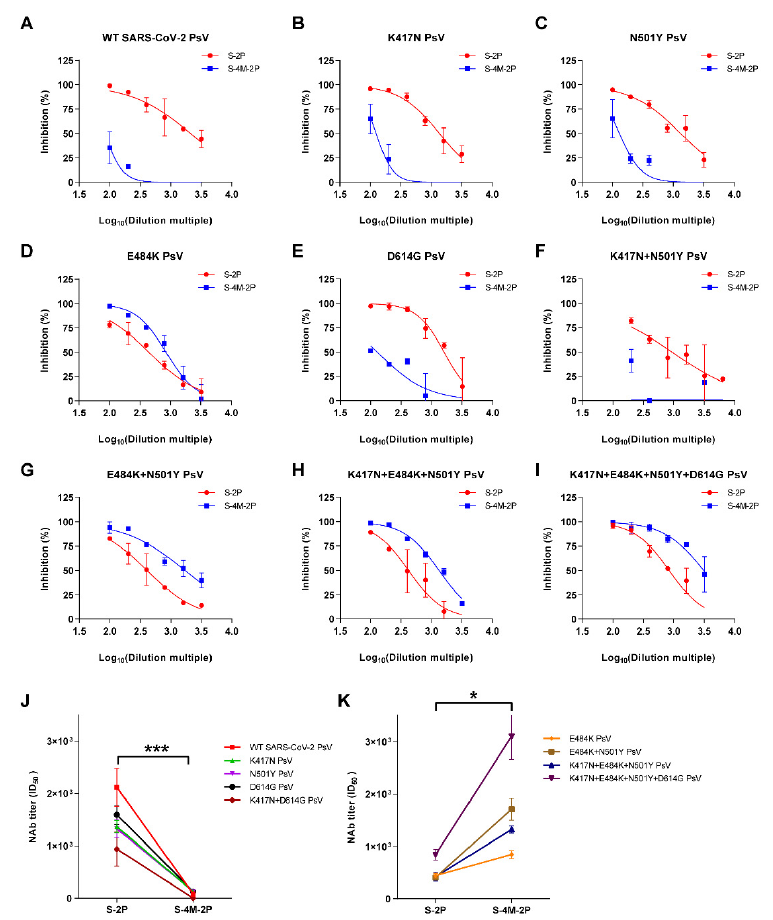
Figure 3. Neutralizing antibodies elicited by S-4M-2P mostly targeted the mutant residue K484 but not the wild-type residue E484. Boost sera from the high-dose (1 µ g) vaccinated mice group were collected at 28 days after initial vaccination and mixed together in equal quantities. Pseudovirus-based neutralization assays were performed to detect neutralizing antibody titers (ID 50 ) of sera against pseudotyped virus carrying wild-type spike or spike with single or multiple mutations. Represen- tative neutralization curves of boost sera from mice vaccinated with 1 µ g S-2P or S-4M-2P protein against pseudotyped virus carrying wild-type SARS-CoV-2 spike ( A ) or spike carrying the K417N ( B ), N501Y ( C ), E484K ( D ), D614G ( E ), K417N+N501Y ( F ), E484K+N501Y ( G ),